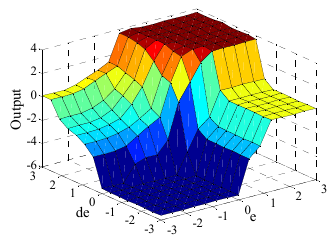
Figure 17. Slip speed output surface.